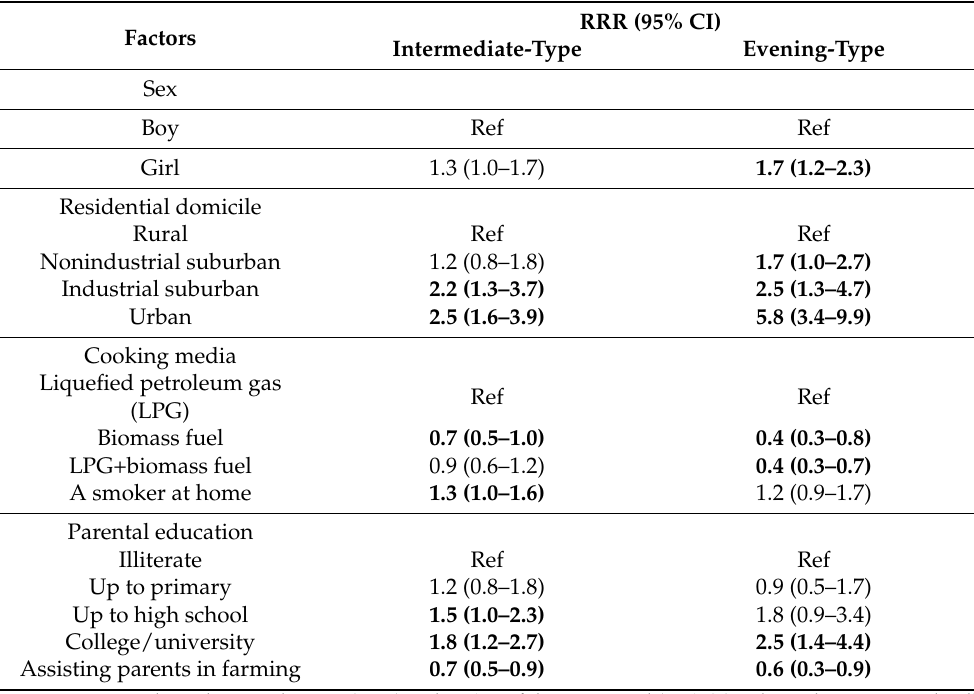
Table 3. Association between living conditions/socioenvironmental factors and chronotype consider- ing morning type as the base outcome in the multinomial logistic regression